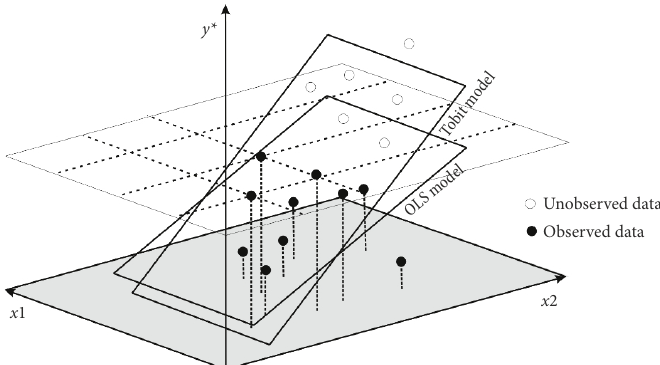
Fig. 5. Tobit model